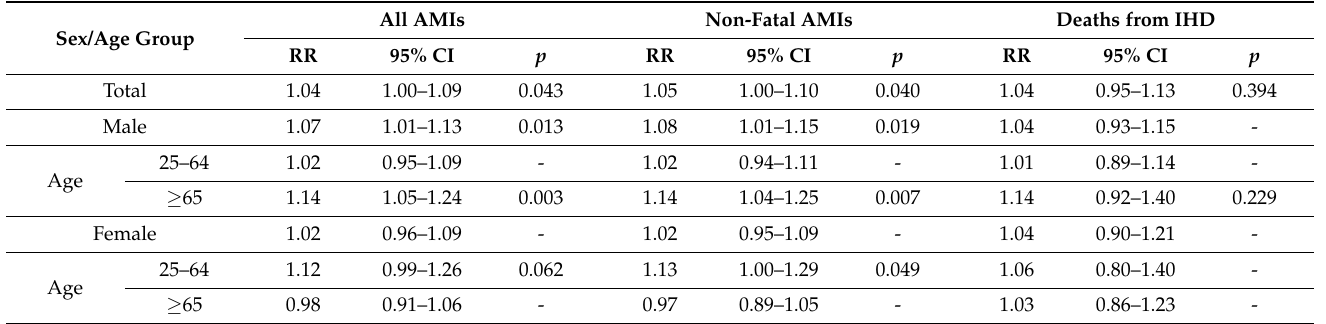
Table 8. The effect of HSSW (daily solar wind speed >530 km/s) on the risk of AMIs and deaths from IHD by sex and age